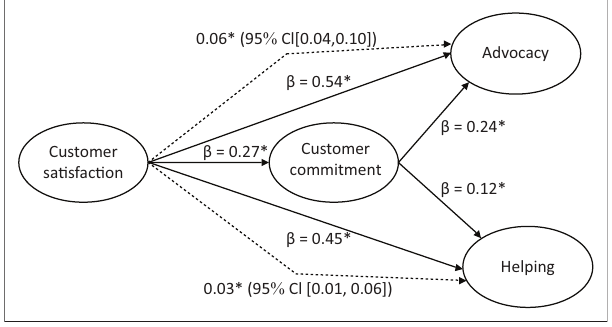
FIGURE 2: Structural model.